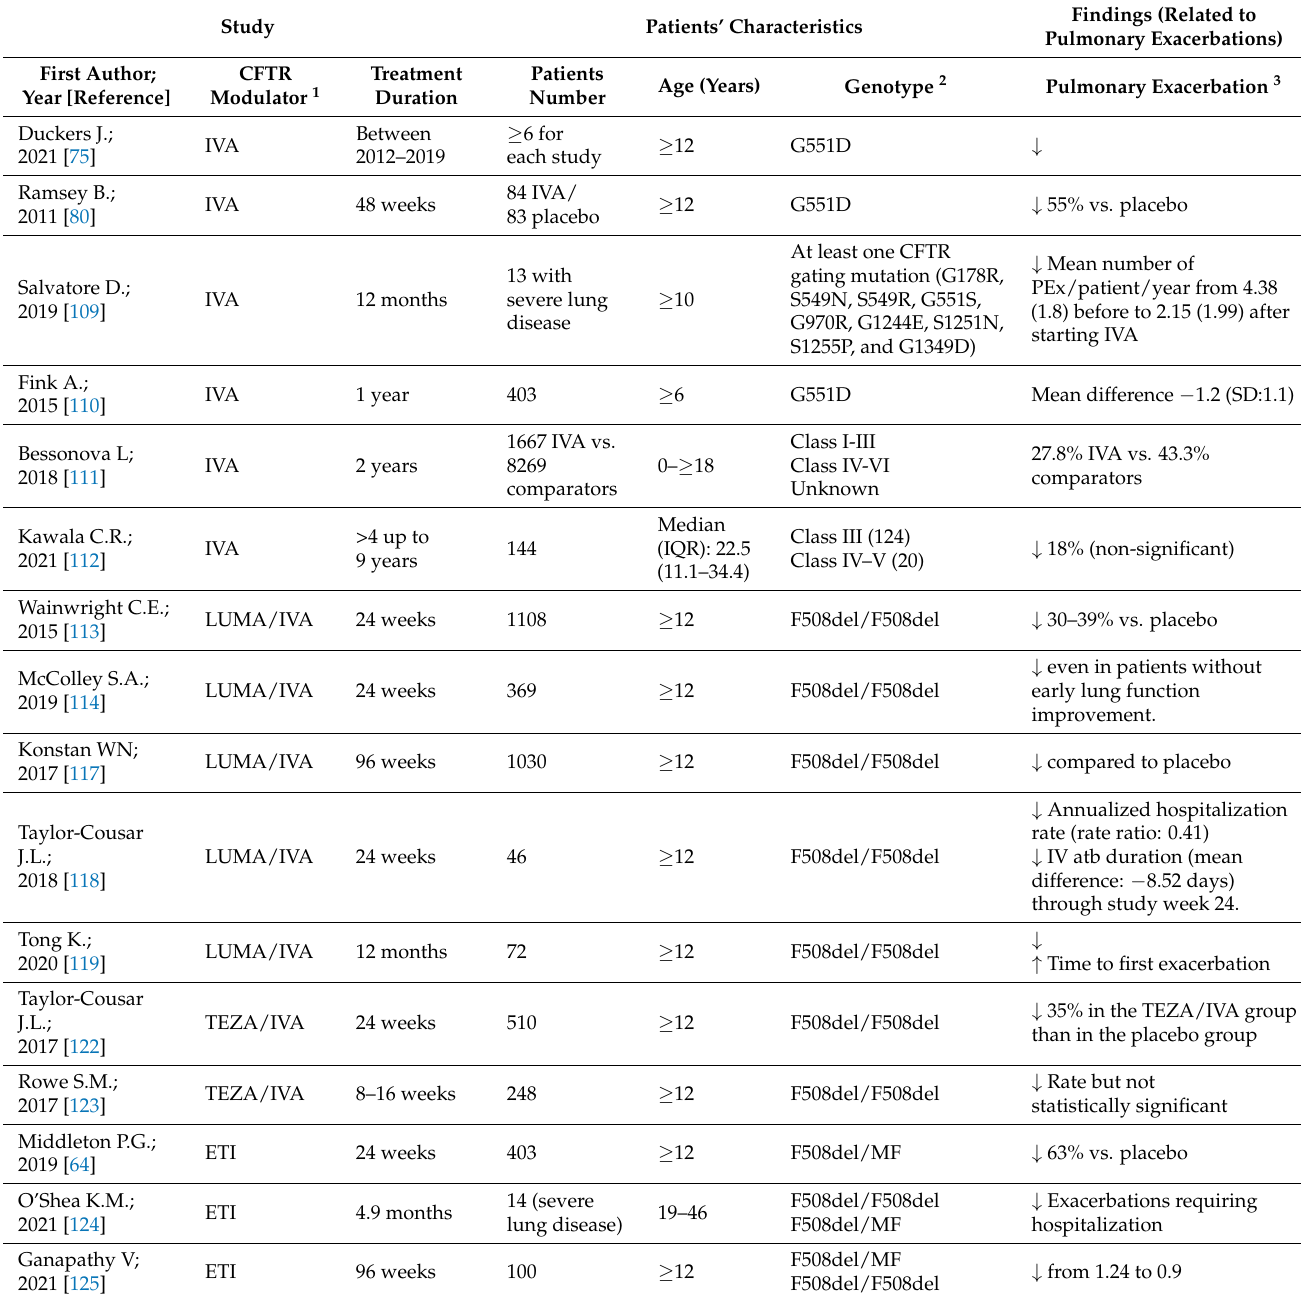
Table 3. Effects of CFTR modulators on pulmonary